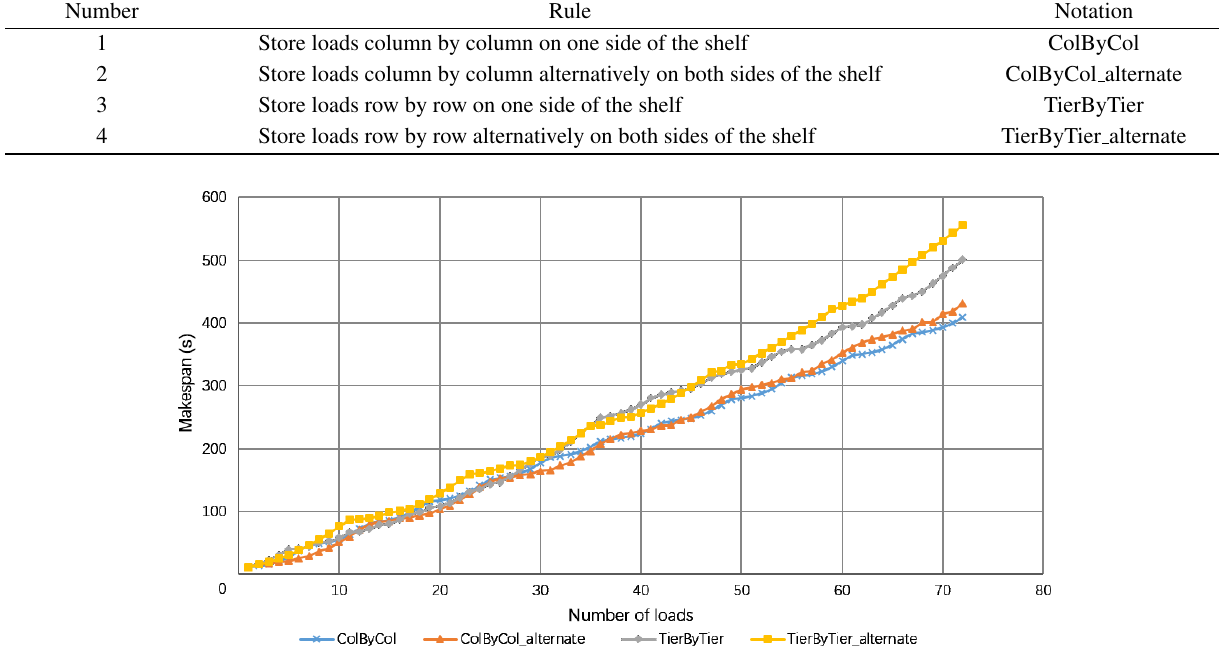
Fig. 4 Makespan as a function of number of loads using the four